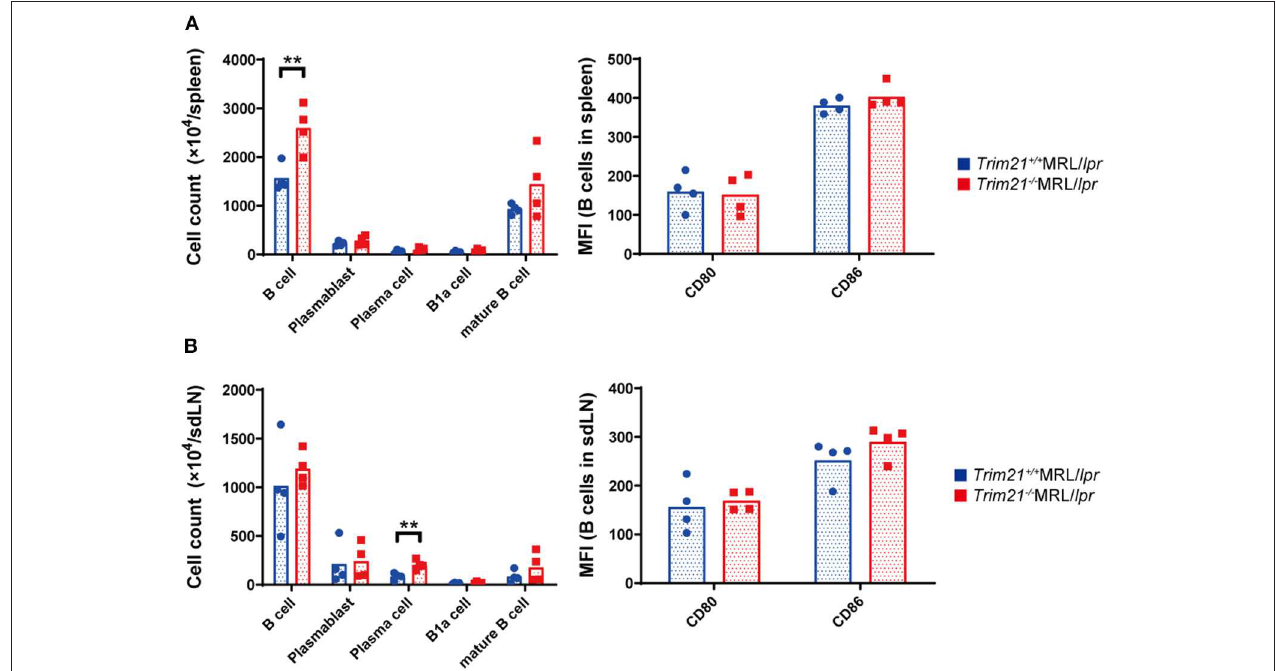
FIGURE 4 | The comparison of B cell subset populations between Trim21 + / + and Trim21 − / − MRL/ lpr mice. Flow cytometric analyses and qPCR analyses were performed for spleen or sdLN cells at 10 weeks of age ( n = 4 in each group). (A,B) B-cell subsets in spleens and sdLNs were classified by surface markers as follows: B cells; B220 + CD19 + , plasmablasts; CD19 + CD138 + , plasma cells; CD19 − CD138 + , B-1a cells; IgM + CD5 + CD1d − and mature B cells; IgM + IgD + CD19 + . Mean fluorescence intensities (MFIs) of CD80 and CD86 were measured in B220 + CD19 + B cells. Statistically significant data (** p < 0.01) by Student’s t -test.